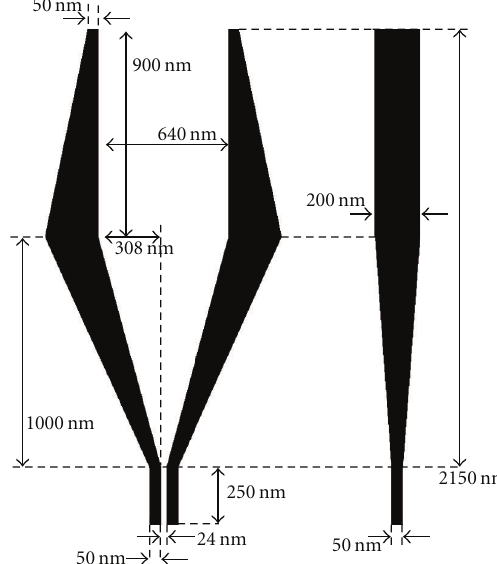
Figure 4: Geometry of the proposed new directional nanoantenna: top view (left) and side view